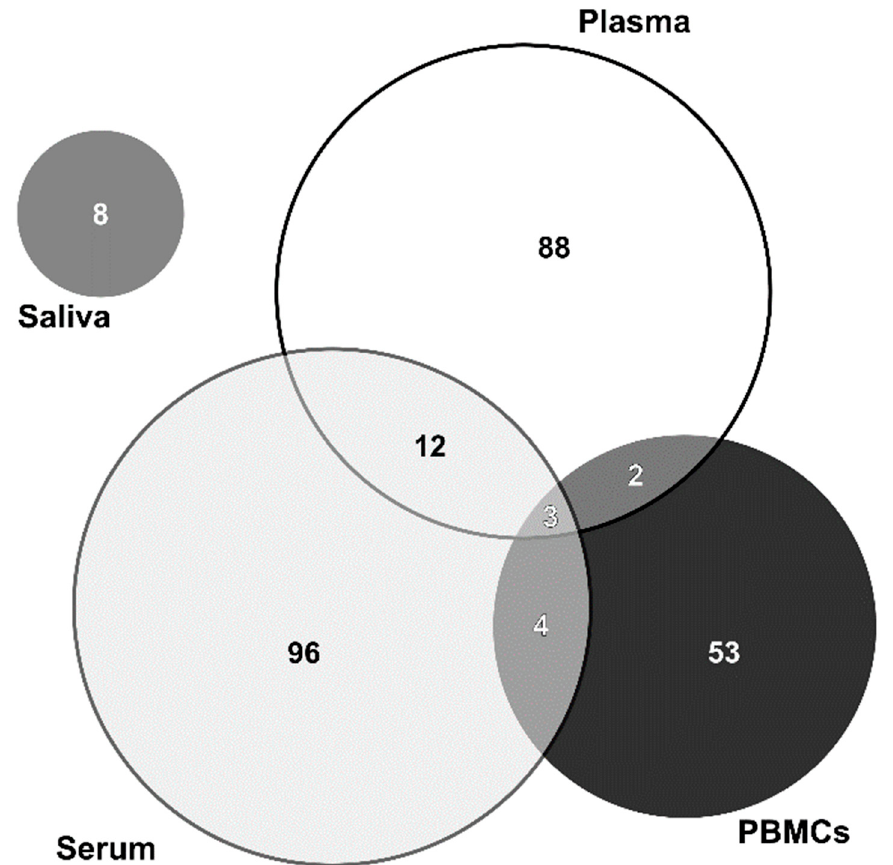
Figure 2. Venn diagram of proteins identified as altered in blood samples (plasma, serum, and PBMCs) and the whole saliva in the selected studies of bipolar disorders (BD) vs. control. The proteins identified as altered in the (i) plasma vs. serum vs. PBMCs (3 proteins), (ii) plasma vs. serum (12 proteins), (iii) plasma vs. PBMCs (2 proteins), and (iv) serum vs. PBMCs (4 proteins). The proteins found as altered in the saliva study were not coincidental with the proteins found in the blood studies (see text for details).